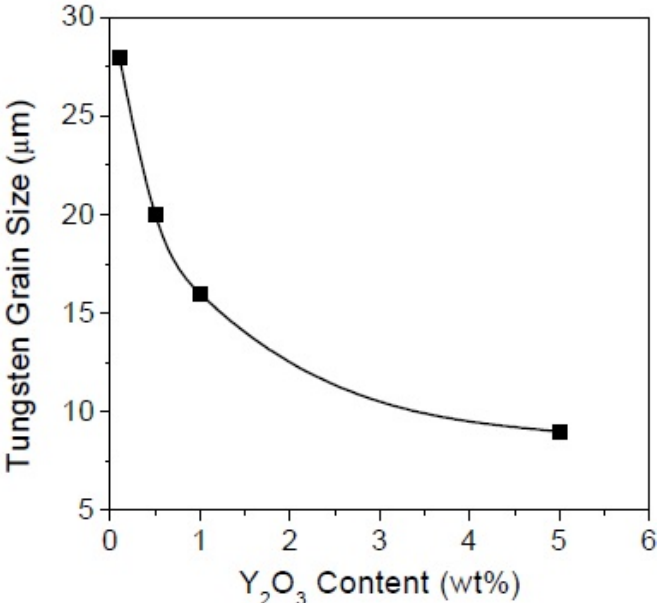
Figure 12. Variation in grain size in mechanically alloyed and sintered W-5.6Ni-1.4Fe with increasing Y 2 O 3 content [80]. Reproduced with permission from Ryu et al., Materials Science and Engineering: A; published by Elsevier, 2003.